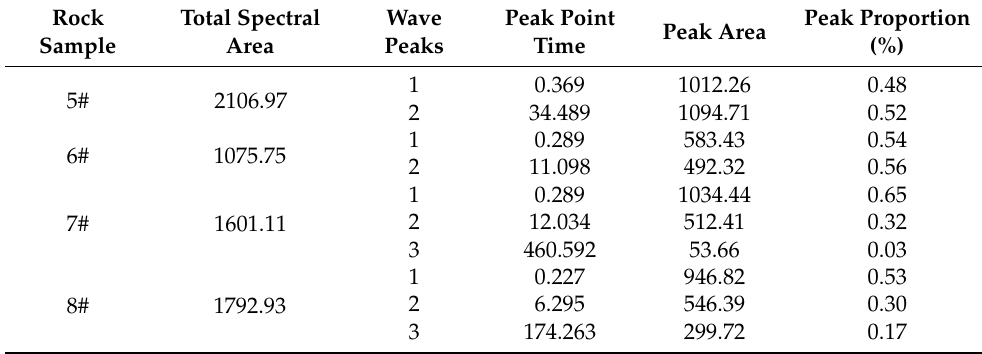
Table 8. Magnetic resonance data of carbonate rocks.